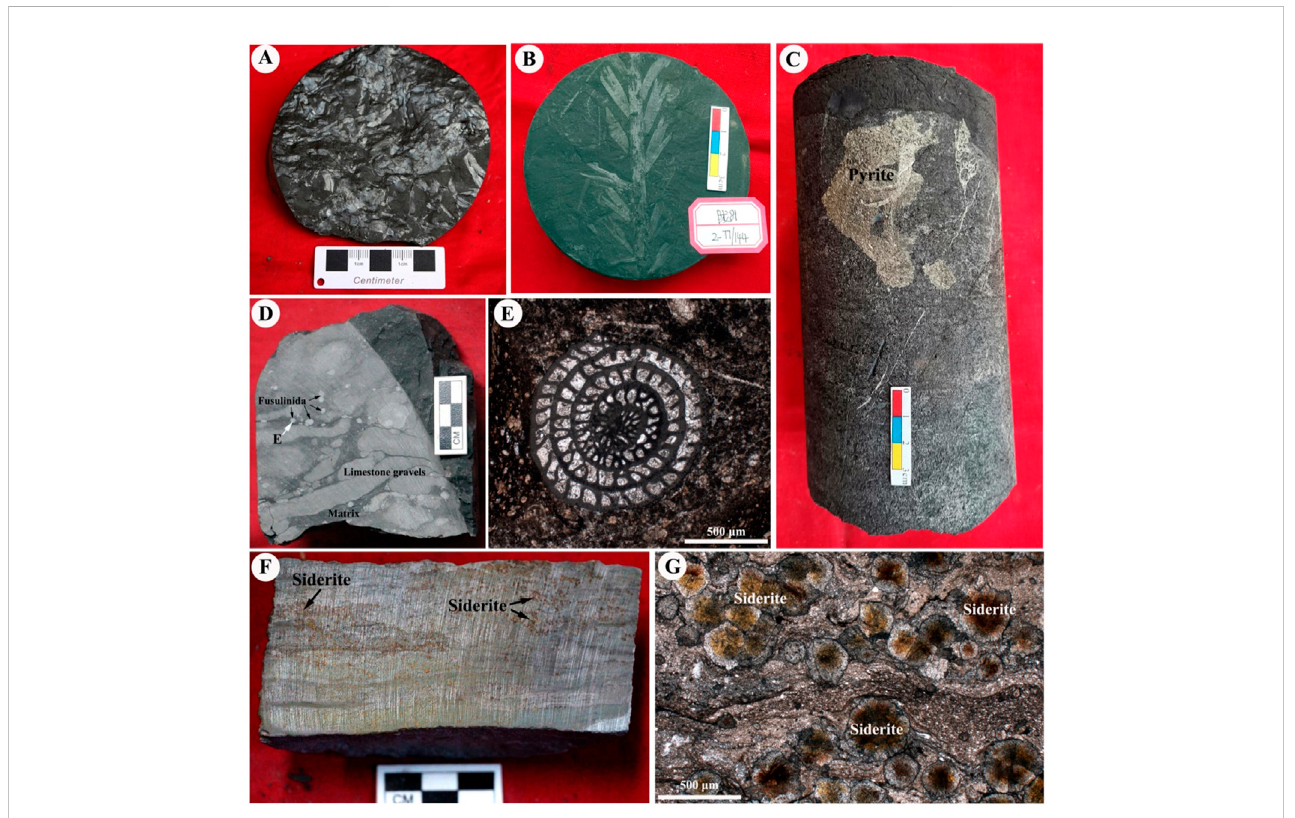
Depositional environment indicators in the core samples and thin sections from the Taiyuan Formation in the Ordos Basin [ (A) , Cordaites fossil, L47-1 well, 4120m; (B) , Cordaites fossil, L81 well; (C) , Pyrite crystal, HT7 well, 4435.0m; (D, E) , Fuzulinid fossil and limestone gravels, L66 well, 4040.5 m; (F, G) , Nodular siderite, L65 well, 4296.3 m].